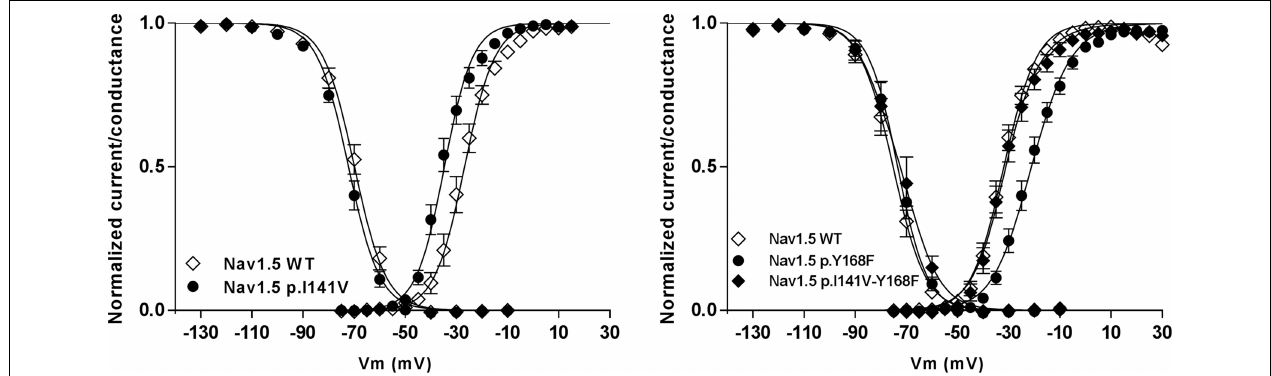
voltage dependence of activation. However, this effect was abolished in the presence of the p.Y168F substitution (right panel); (From Amarouch et al.,